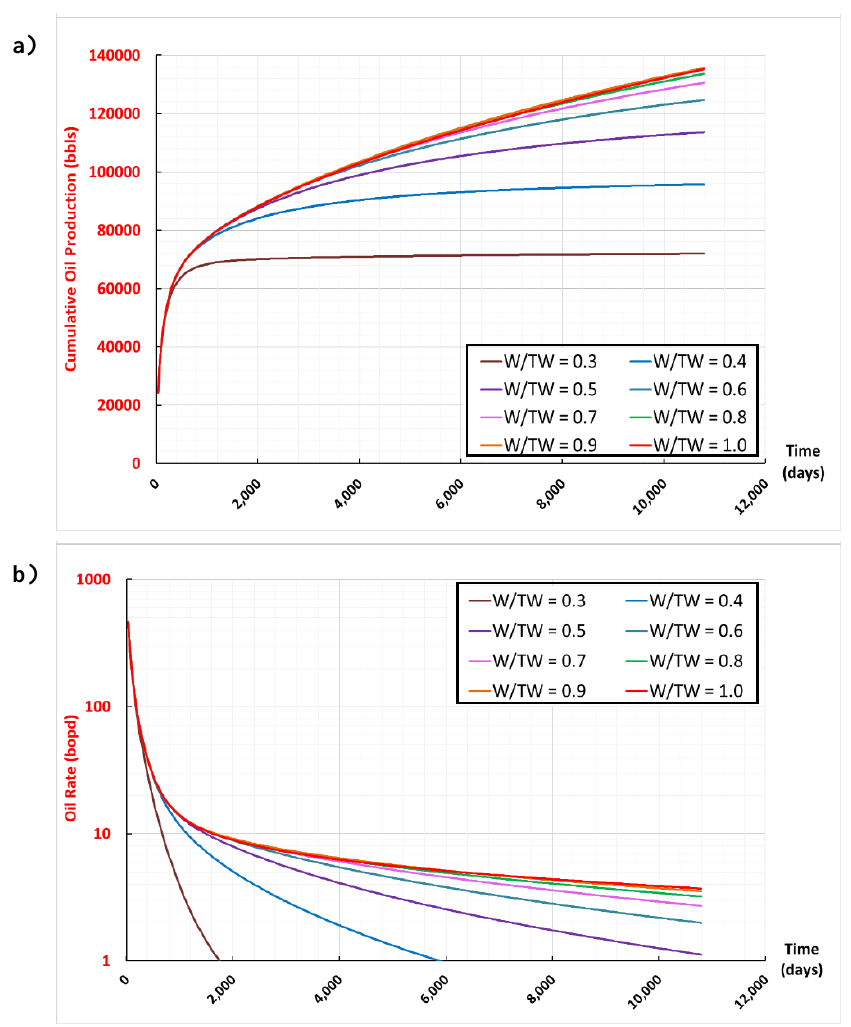
Figure 12. Numerical (KAPPA) model forecasts. ( a ) Cumulative production, and ( b ) log rate versus time plot, for W / TW = 1.0 to W / TW = 0.3 cases. After Figure 12: Numerical (KAPPA) model forecasts. (a) Cumulative production, and (b) log rate versus time plot, for W/TW=1.0 to W/TW=0.3 cases. After [7].